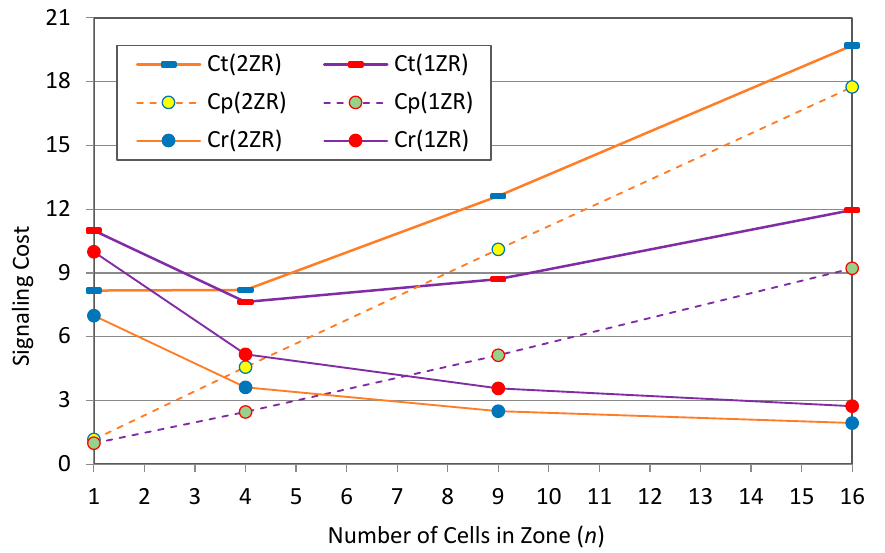
Figure 11. Total signaling cost for various numbers of cells in a zone ( λ m = 4, λ c = 2, q = 0.3).